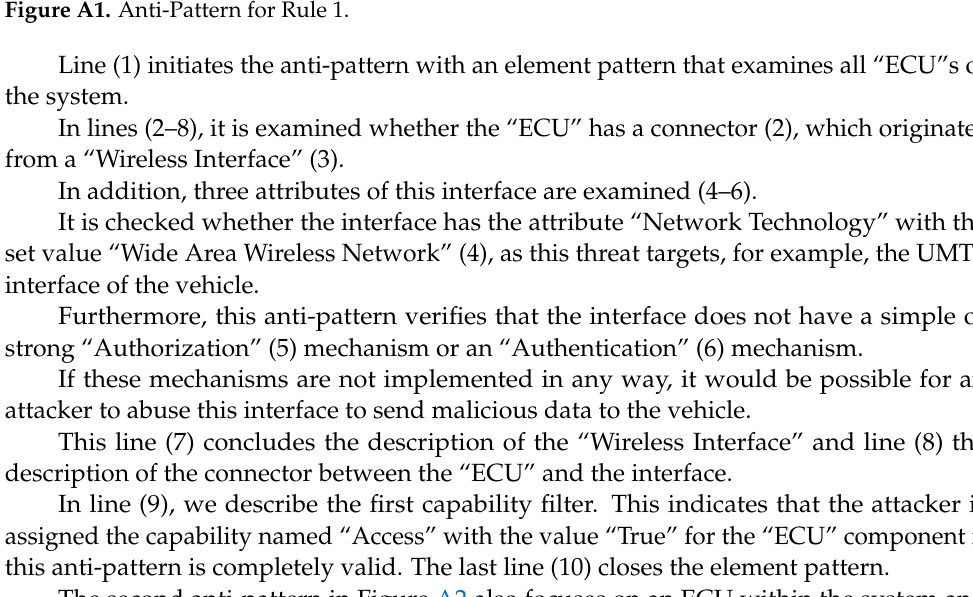
Figure A1. Anti-Pattern for Rule